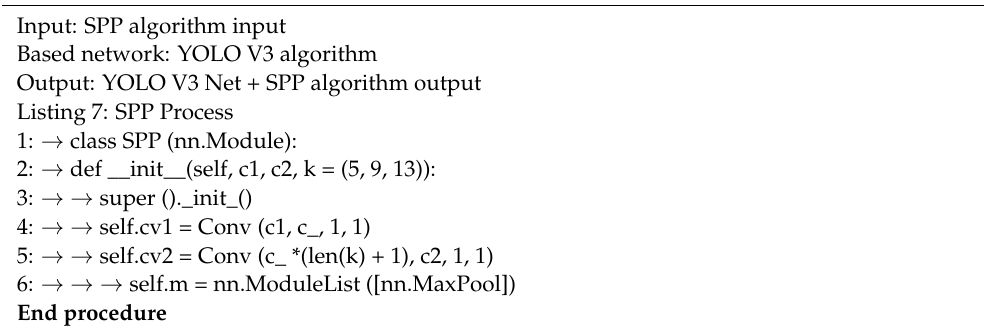
Algorithm 7 : Online Datasets Preprocessing YOLO V3 + SPP